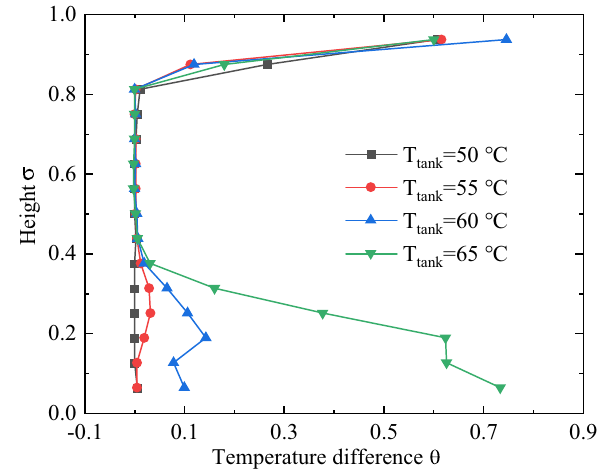
Fig. 19 Temperature changes of L1 when Re is 2633 and Fo is 0.9 in forward flow